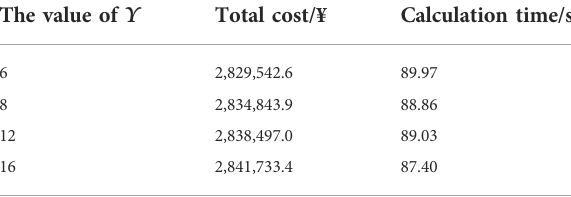
TABLE 8 In fl uence analysisofconservatism parameterson the